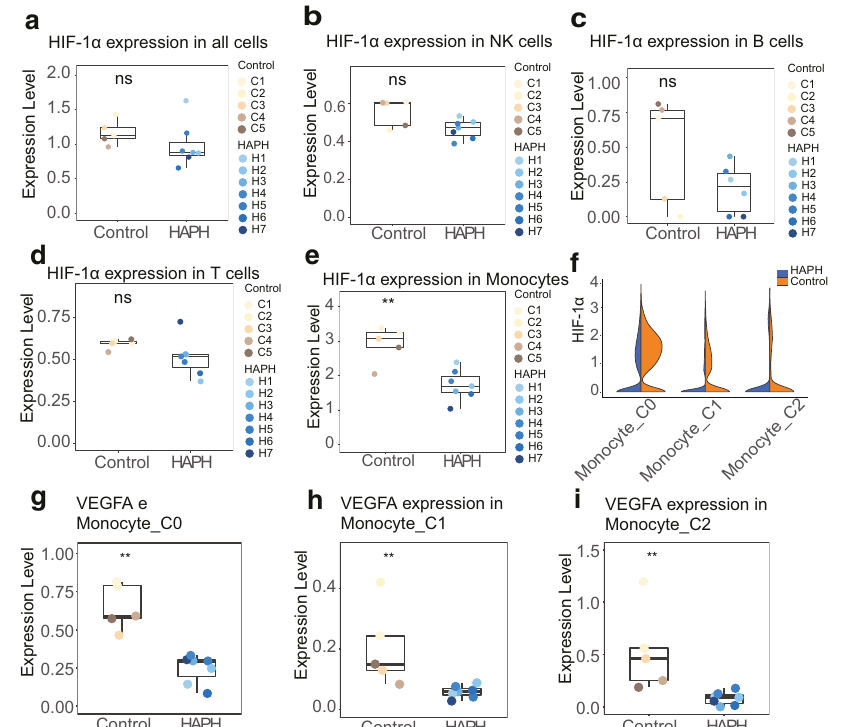
Fig. 6 | Comparison of the expression of HIF-1 α and VEGF1 in immune cell population between HAPH and controls. Box plots displaying the expression of HIF-1 α in HAPH patients relative to that in controls in indicated cell population ( a : all cells, b : NK cells, c : B cells, d : T cells, and e : monocytes). ** p < 0.01; n.s. not signi fi cant byunpaired two-sided t test. f Box plots showing the comparison ofthe